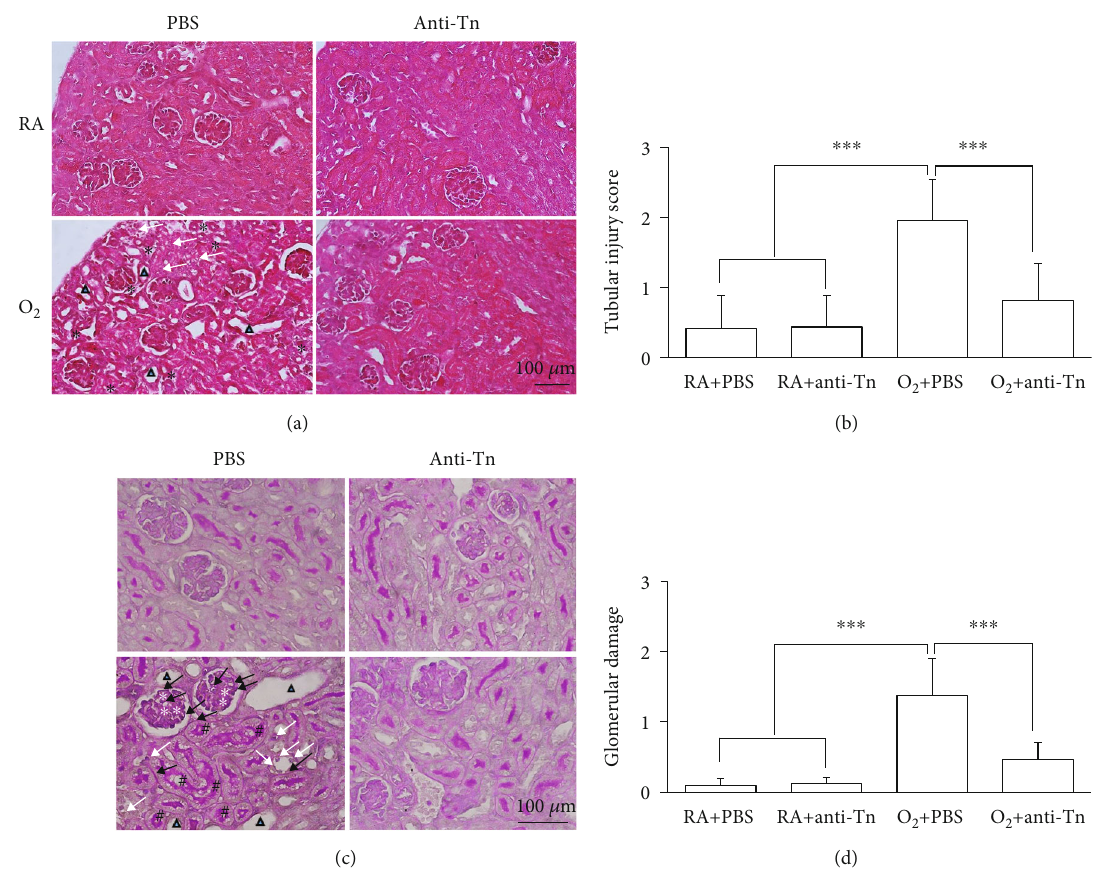
Figure 1: Representative kidney sections stained with (a) hematoxylin and eosin, (b) PAS, and (c) tubular injury score and (d) glomerular damage from the RA-reared and hyperoxia-reared mice treated with PBS or anti-Tn monoclonal antibodies on postnatal day 7. The mice reared in RA and treated with PBS or anti-Tn monoclonal antibodies exhibited no glomerular injury, acute tubular necrosis, or tubulointerstitial in fl ammatory in fi ltrates. The mice reared in hyperoxia and treated with PBS exhibited tubular atrophy, dilatation of the tubular lumen (triangles), degenerated tubular cells (white arrows), increased space between the renal tubules (black asterisks), distortion of the free surface of tubular cells (hashtags), thickened basement membrane of glomerular capillaries and renal tubules (black arrows), and mesangial expansion between the glomerular capillaries (white asterisks). Anti-Tn monoclonal antibody treatment improved hyperoxia-induced kidney injury. ∗∗∗ P < 0 : 001 . Table 1: Kidney injury scores of histological changes in the